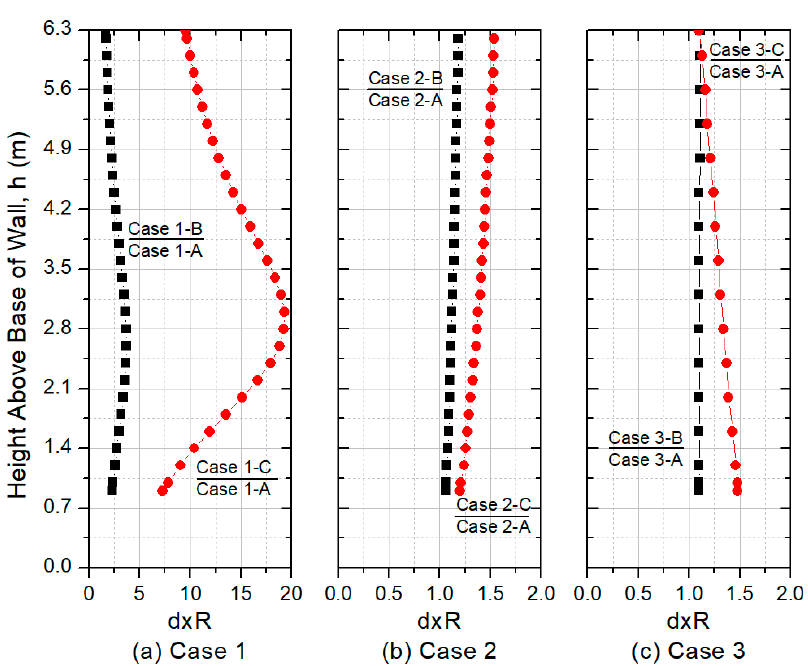
Figure 8. Lateral displacement ratio, dxR , at the wall facing, showing the increase of dx after the applied surcharge loads.